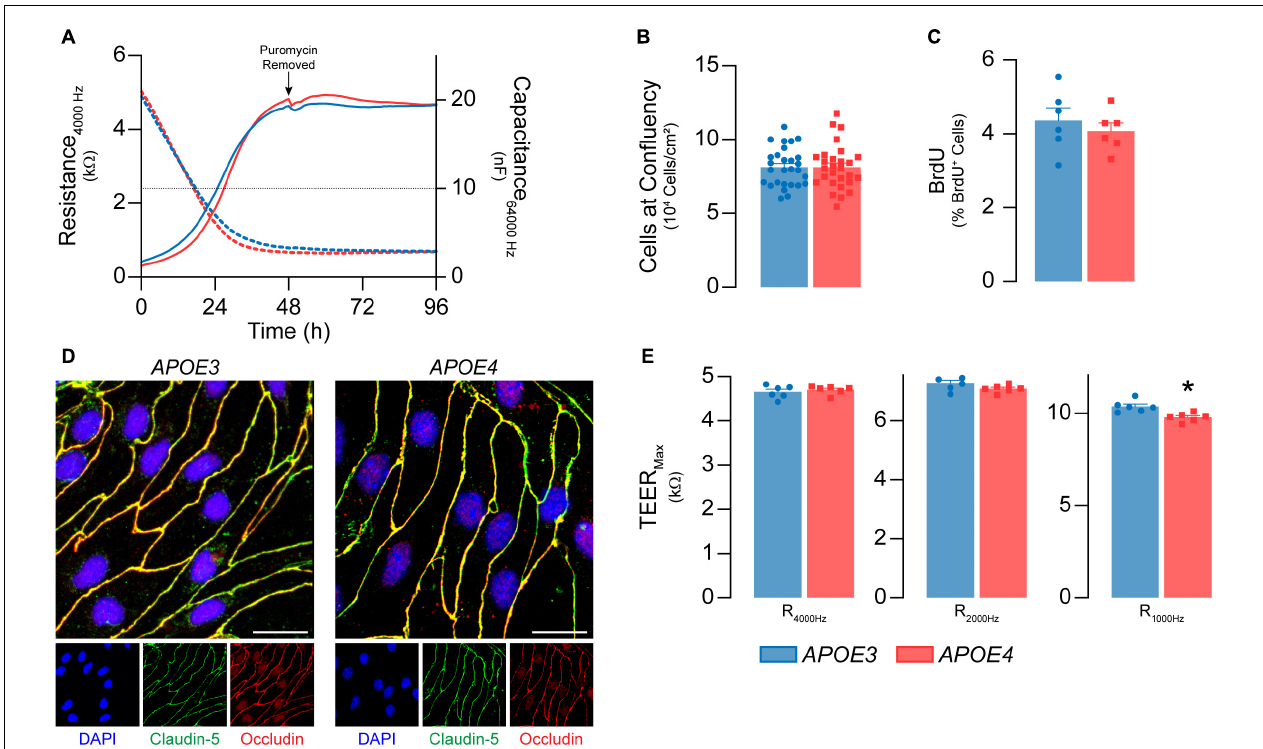
FIGURE 1 | Primary mouse brain endothelial cell characterization at passage 0. (A) Following isolation, brain endothelial cells establish a confluent monolayer. Capacitance (dashed lines) measured at 64 kHz reflects cell attachment and spreading and decreases as cell coverage increases; capacitance plateaus below 10 nF (black dotted line) once a monolayer is established (ECIS R (cid:13) Z (cid:50) Applied Biosystems). APOE3 and APOE4 brain endothelial cell cultures establish a monolayer by 48 h, with no genotype differences. At confluence, there are no differences in (B) cell density ( n = 28) or (C) BrdU + nuclei ( < 5%) between APOE3 and APOE4 brain endothelial cells. (D) APOE3 and APOE4 brain endothelial cells express the tight junction protein markers claudin-5 (green) and occludin (red), and exhibit classical endothelial cell morphology (narrow, elongated, tightly packed cells) when assessed by immunocytochemistry, scale bar = 20 µ m. (E) When impedance is measured at lower frequencies (i.e., 4000, 2000, and 1000 Hz), more current passes between the cells and is therefore a measure of paracellular permeability referred to as transendothelial electrical resistance (TEER). At all frequencies, TEER (solid lines in A ) progressively increases over the course of 48 h and is then maintained for